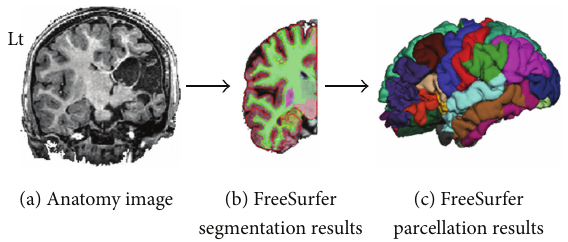
Figure 1: Parcellation of the hemisphere contralateral (CLH) to the lesion in a 7-year-old female with right lesion. (a) High-resolution anatomical 3D 𝑇 1 W image; (b) FreeSurfer segmentation results in the CLH; (c) 3D visualization of cortical parcellation obtained for the left